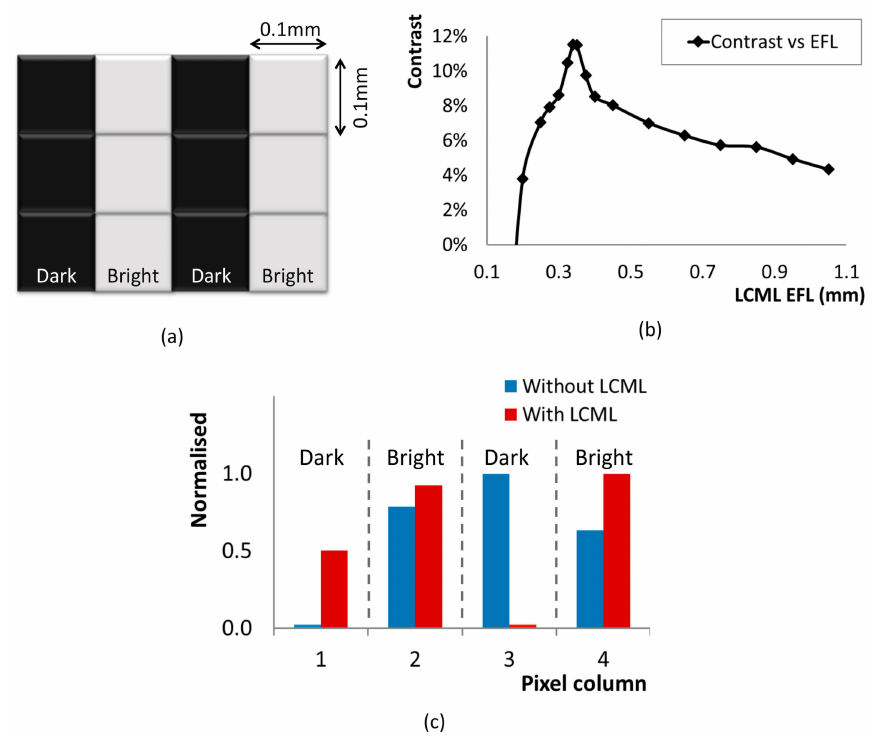
Figure 3. ( a ) Test object pattern of 4 × 3 square image pixels; ( b ) Simulated contrast with respect to varying LCML EFL; ( c ) Normalised light irradiance of the TFPT imager without and with an LCML